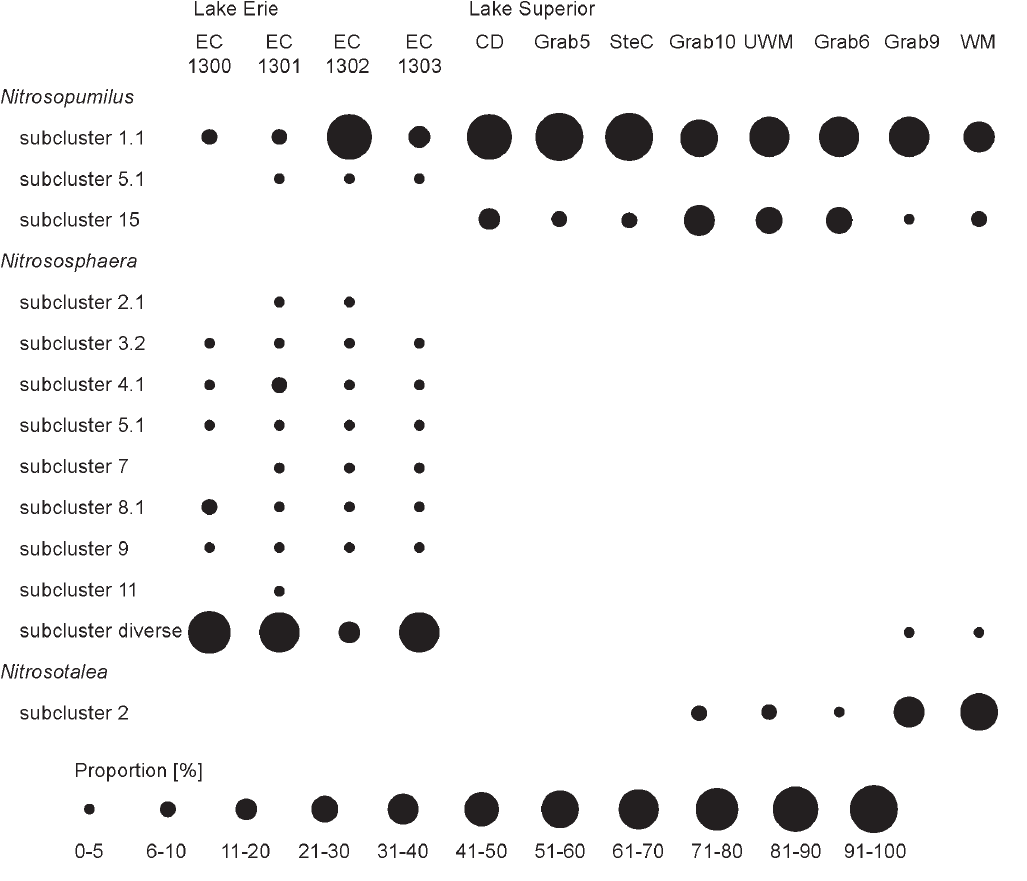
Figure 4. Relative frequency [%] of the AOA in the different phylogenetic groups. Representative sequences were picked based on 98% identity, aligned in ARB to the AOA tree published by Pester et al. (2012) and assigned to different phylogenetic groups. Cultivated members of the AOA can be found in Nitrosopumilus cluster 1.1: Nitrosopumilus maritimus , Candidatus Nitrosoarchaeum limnia, Candidatus Nitrosoarchaeum korensis MY1 and Enrichment AOA-AC2; Nitrosopumilus cluster 5: Enrichments AOA-AC1, AOA-AC5 and AOA-DW. Most cultivated strains are integrated in Figure S3. doi:10.1371/journal.pone.0097068.g004 PLOS ONE |